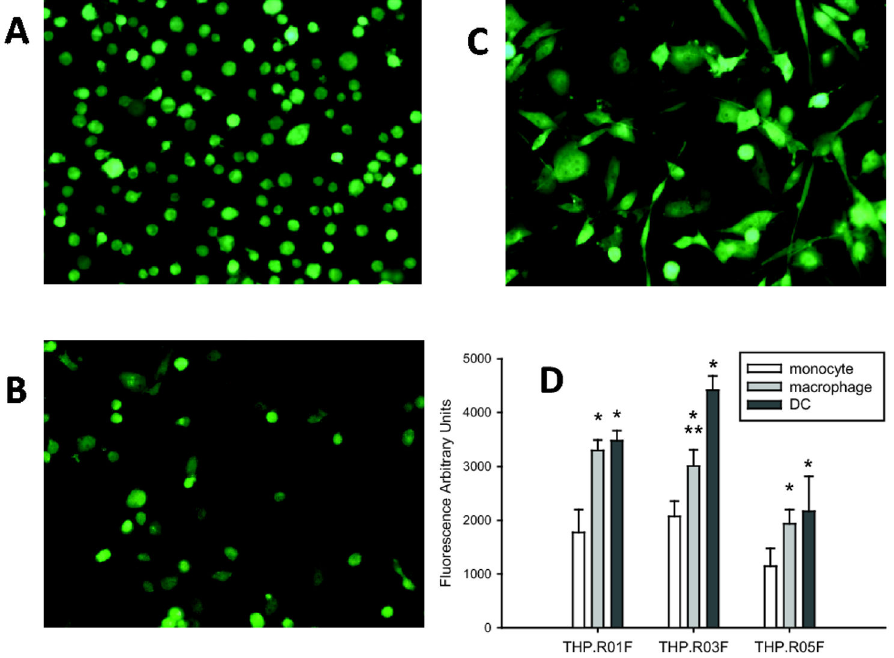
Figure 4. Differentiation of THP.R01F monocytes does not interrupt with the GFP reporter activity. Monocytic THP.R01F ( A ) were transformed into macrophages ( B ) upon treatment with 100 ng/mL PMA for 3 days. Alternatively, treatment of the monocytes with 100 ng/mL GM-CSF and 200 ng/mL IL-4 for 16 hours, followed by 20 ng/mL TNFα and 200 ng/mL ionomycin, produced mature dendritic cells ( C ) within next two days. 96-Well assay plates were seeded with 2×10 4 THP.R0nF cells (n = 1, 3, or 5 for NF-κB, HIF-1α, or Nrf2 reporters, respectively) per well, six wells per cell line. The cells were differentiated as above, lysed, and relative fluorescence of the lysates was measured ( D ). The bars and error bars are fluorescence means ± SD, n = 6; statistical analysis: one-way ANOVA, with pairwise multiple comparisons by Holm-Sidak test. Statistical significance *: compared to white bar; **: compared to dark grey bar; in all cases, P <0.01. doi: 13-fold difference with the minimally active macrophages (MTHP.R03F, Figure 5B inset). Upon stimulation with hypoxia mimics CoCl and o-phenanthroline, however, the strongest 2 response was detected in the macrophages, 24-fold increase, and DCs (16-fold), also in a dose-dependent manner (Figure 5B). Interestingly, the NF-κB activator LPS has inhibited the basal HIF-1α activity in all cells.